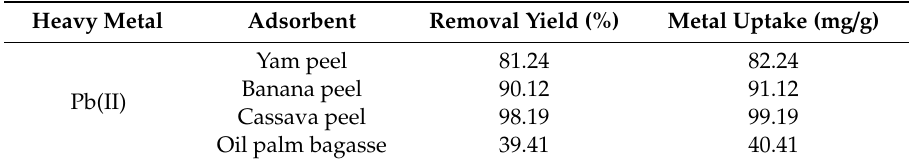
Table 5. Adsorption results of lead ions onto biomass-derived